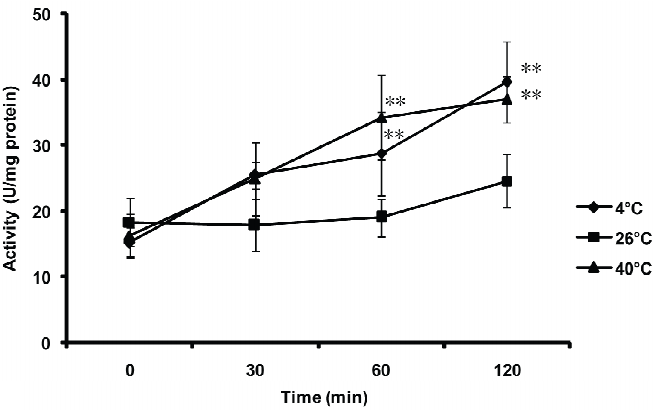
Figure 7. Effect of thermal stresses to MnSOD activity of whitefly in vivo . Each bar represents the mean ± SD of MnSOD activity ( n = 3). Compared with control (0 min), significant differences of each temperature at different sampling times are indicated by two asterisks at p < 0.01 (LSD